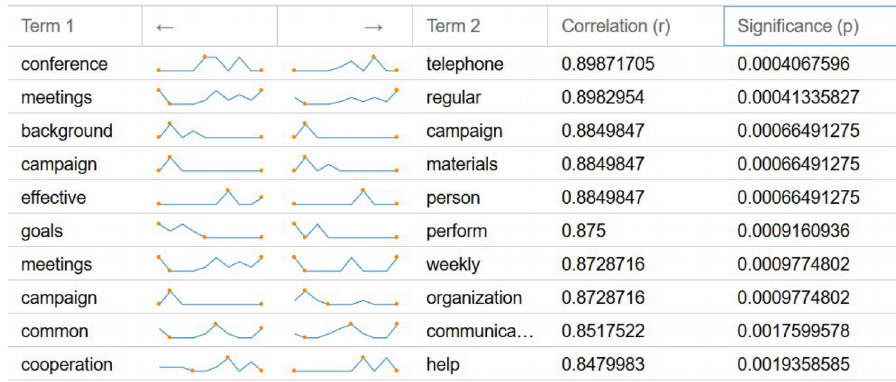
Figure 4. Correlations of words in the answers given to Question 3 (Own editing using www.voyant.tools.org )